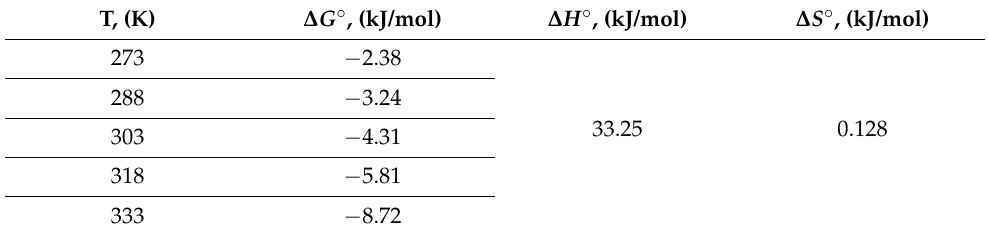
Table 6. Thermodynamic parameters for the adsorption of AZM on